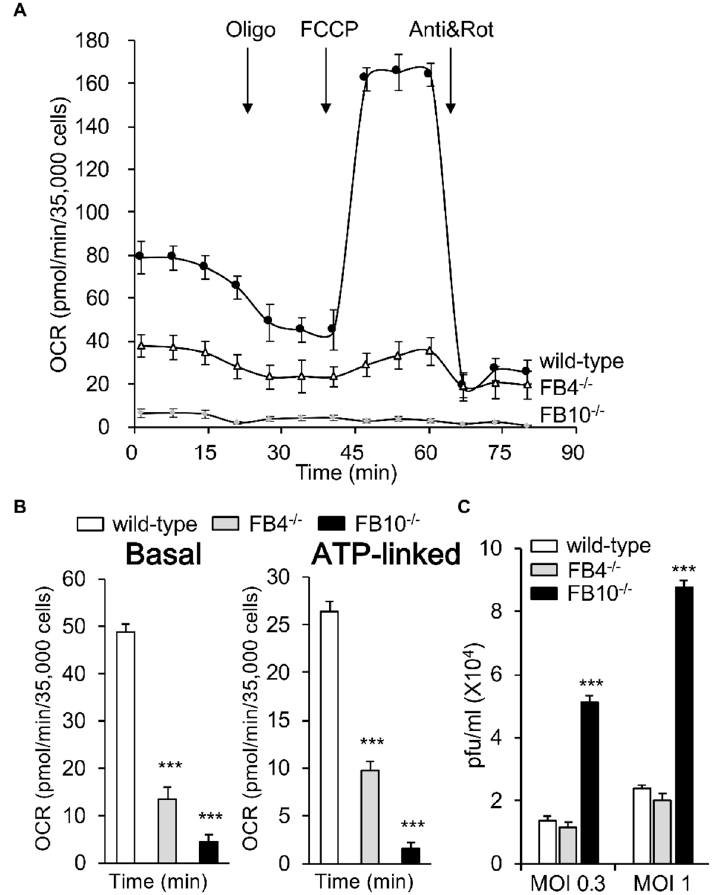
Figure 1. Knock-out (KO) of specific mitochondrial complex I β subcomplex subunit 10 results in reduced mitochondrial respiration; enhanced respiratory syncytial virus (RSV) virus production. Human embryonic kidney (HEK)293T cells and KO derivatives lacking Complex I β subcomplex